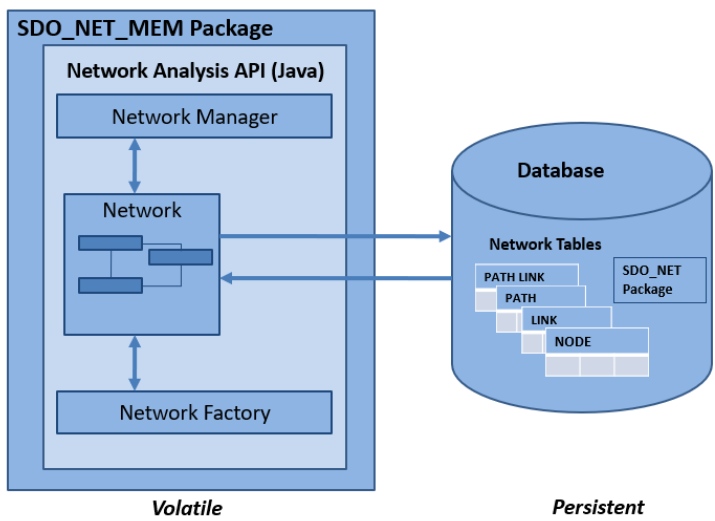
Figure 3. Oracle Network data model (adapted from